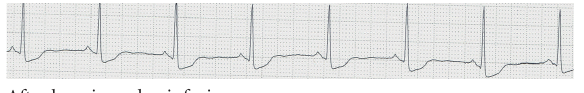
Figure 2: ECG changes in relation to levosimendan